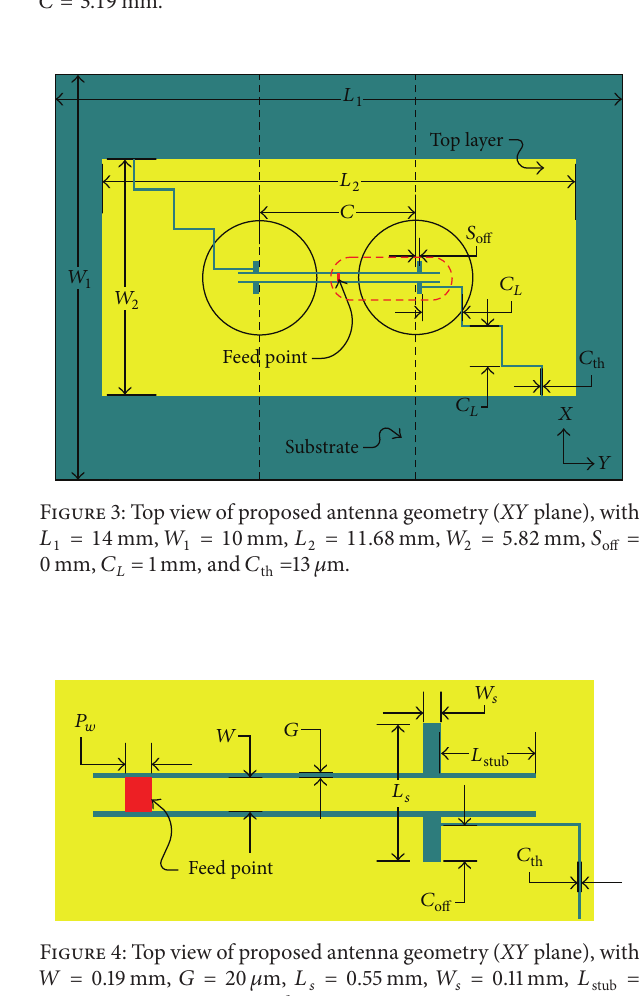
𝑊 𝐿 = 𝑠 = 0.55 mm, 𝑠 = 0.11 mm, stub